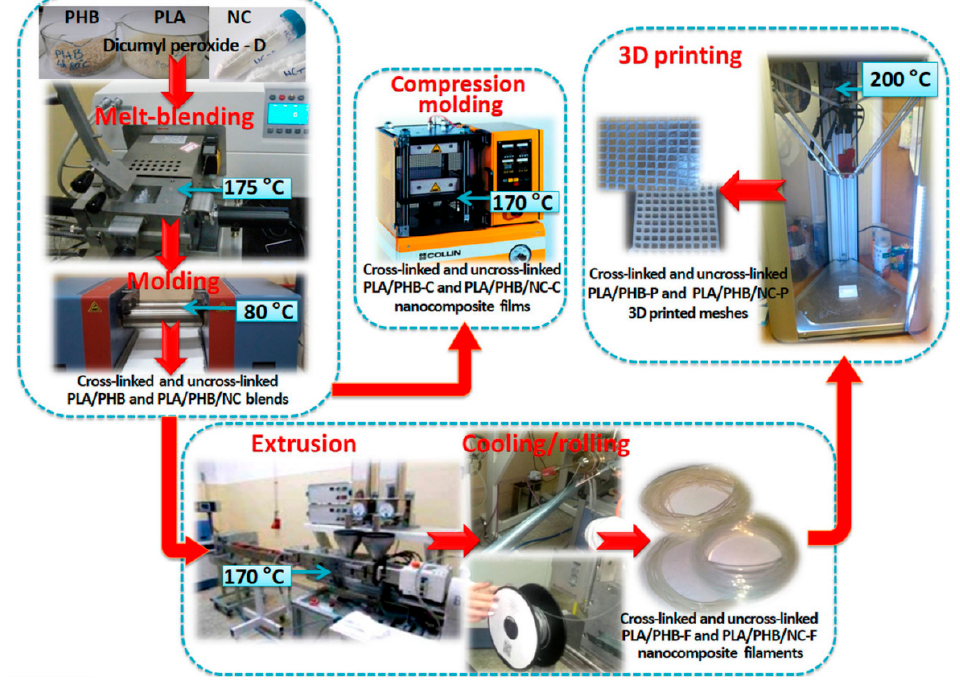
Figure 4. Schematic representation of PLA / PHB blends and nanocomposites preparation and processing of films, filaments, and 3D-printed meshes [90]. Table 3. Recent findings on the cellulose composited in thermoplastic filament for FDM extrusion.